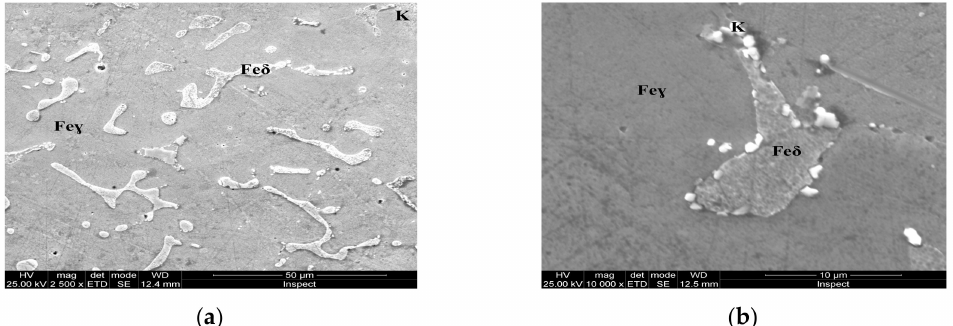
Figure 5. Microstructural aspects of the AISI 316 modified stainless steel sample in the as-cast state (Sample A): ( a ) × 2500; ( b ) detail of the Fe δ phase, × 10,000.